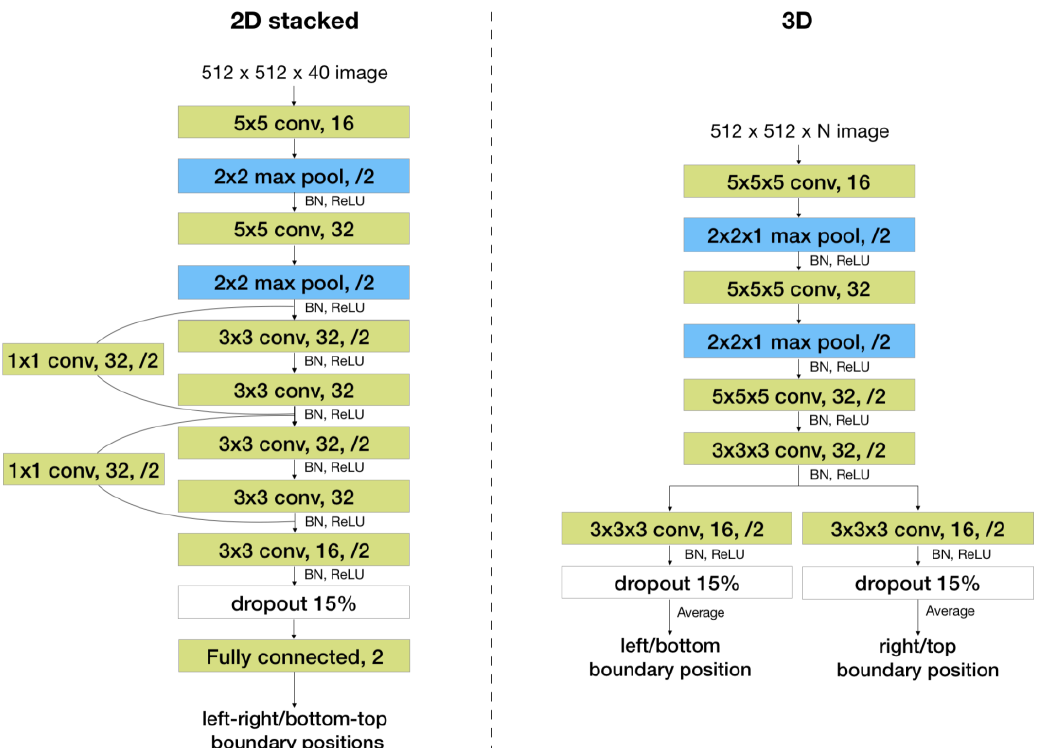
Figure 3. Baseline network architectures of the 2D stacked baseline model ( left ) and the 3D baseline model ( right ). For example, “3 × 3 conv, 32,/2” represents a convolutional layer with 32 kernels of size 3 × 3 and using a stride of 2. BN stands for batch normalization. “Fully connected, 2” represents a fully connected layer with two output nodes.